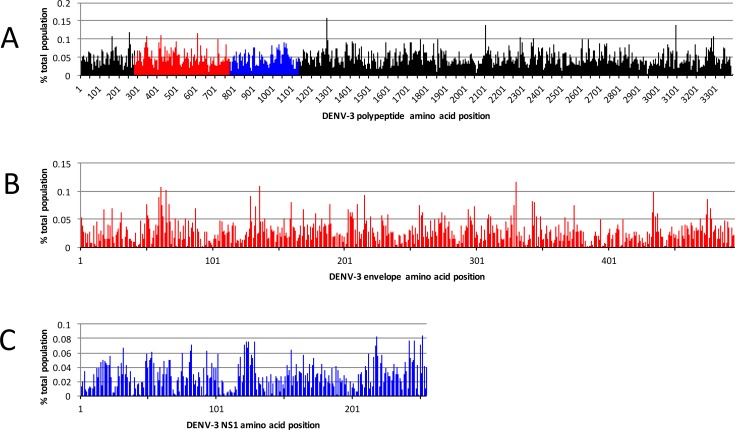
DENV-3 plasmid starting library.DENV-3 antigen fragment plasmid library was assessed by Ion Torrent Deep Sequencing to determine coverage at each amino acid position. (A) Deduced peptide sequences were aligned to the DENV-3 polyprotein with NCBI BLAST and used to determine the coverage at each amino acid position. Each peak represents the % total population of reads representing peptides that align starting at that amino acid position. The red and blue regions represents the E protein and NS1 protein, respectively. (B and C) The E protein and NS1 protein coverage is enlarged from (A) in order to show the coverage of the plasmid library for these regions.